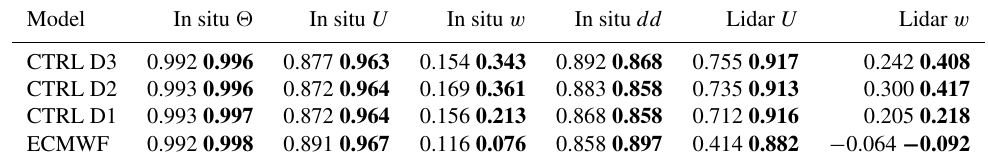
Table 3. Correlation coefficients between airborne in situ and lidar observations and numerical models for potential temperature (cid:50) , horizontal wind speed U , vertical wind speed w , and wind direction dd along all flight legs during both IOP1 and IOP5 (numbers in